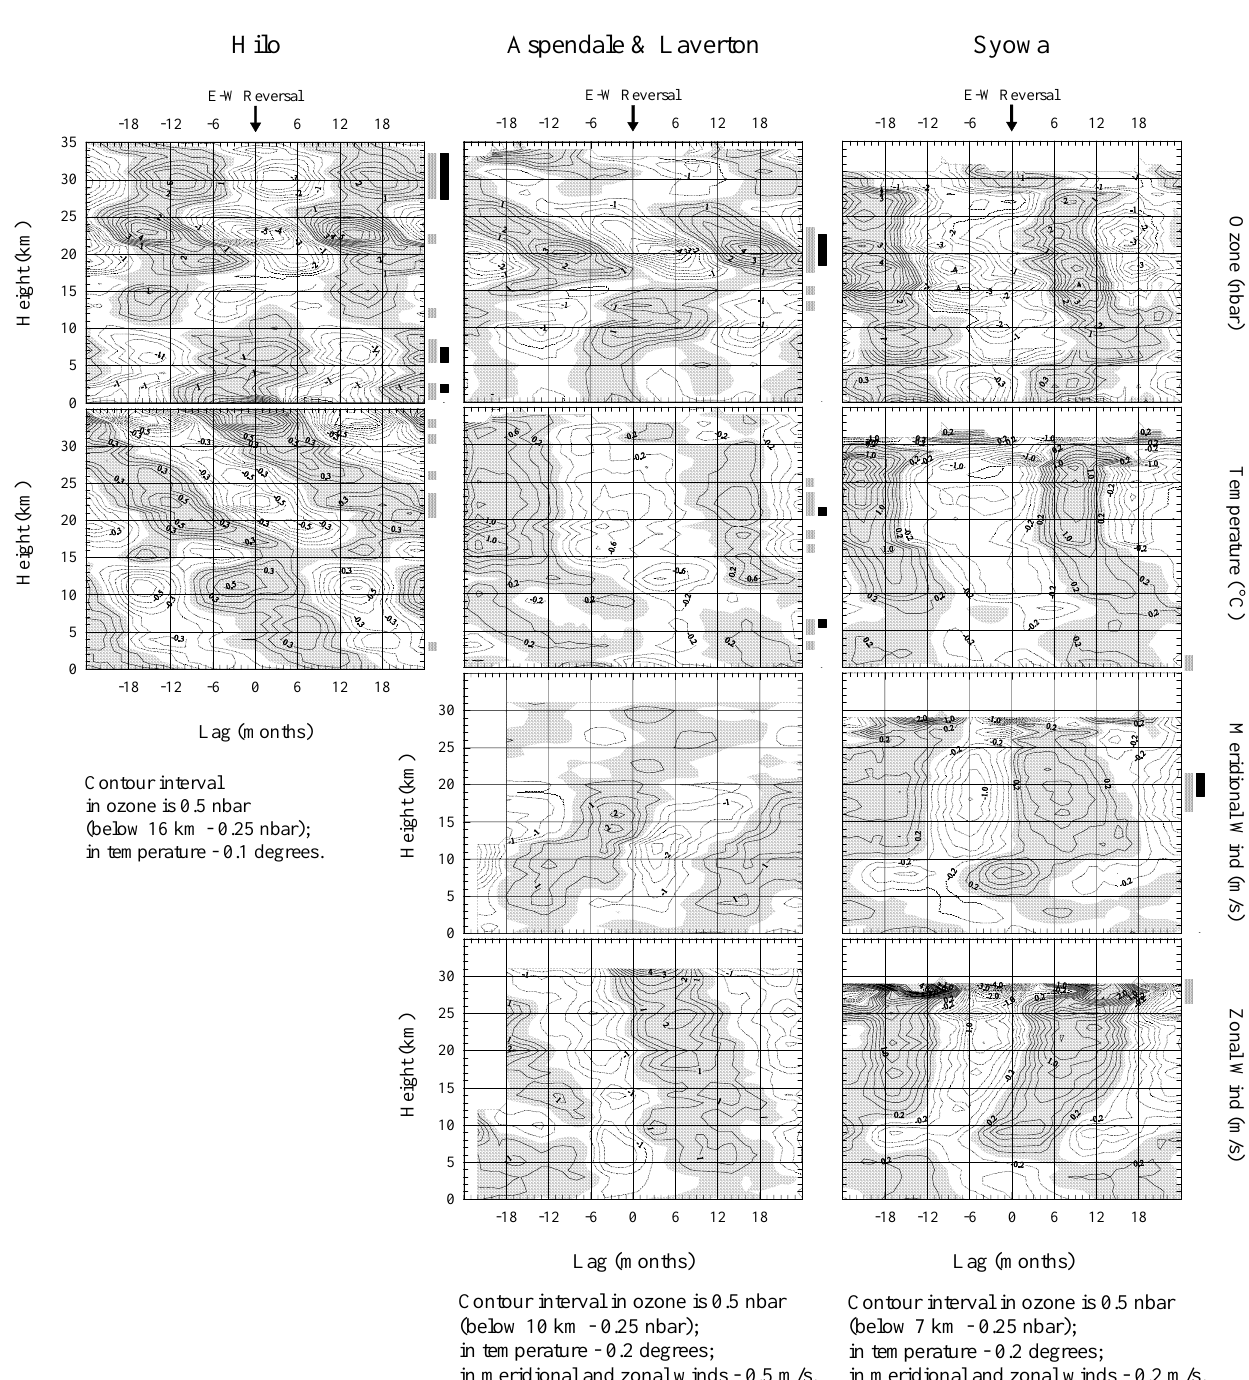
Contour interval in ozone is 0.5 nbar (below 16 km - 0.25 nbar); in temperature - 0.1